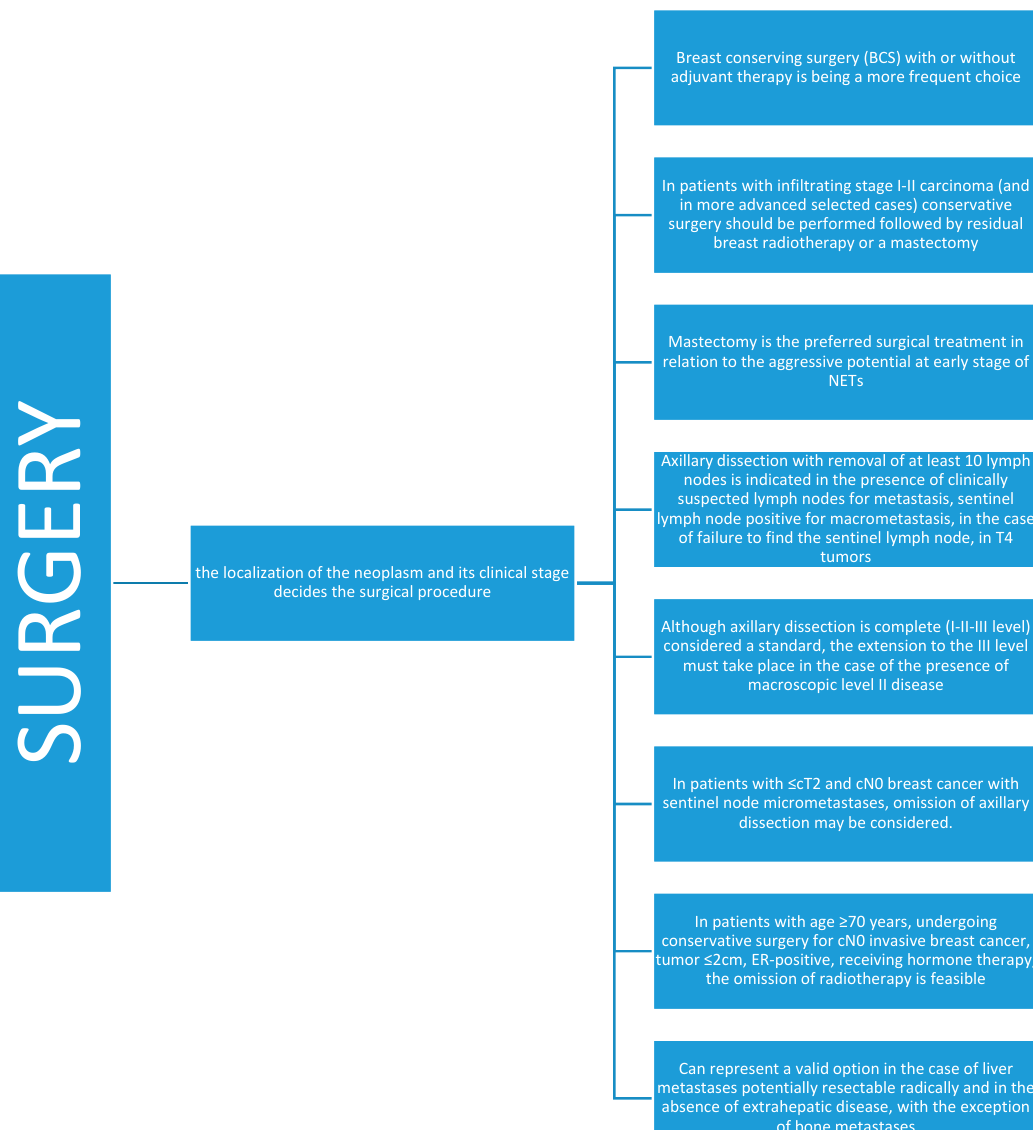
Figure 4. Surgery in neuroendocrine breast cancer